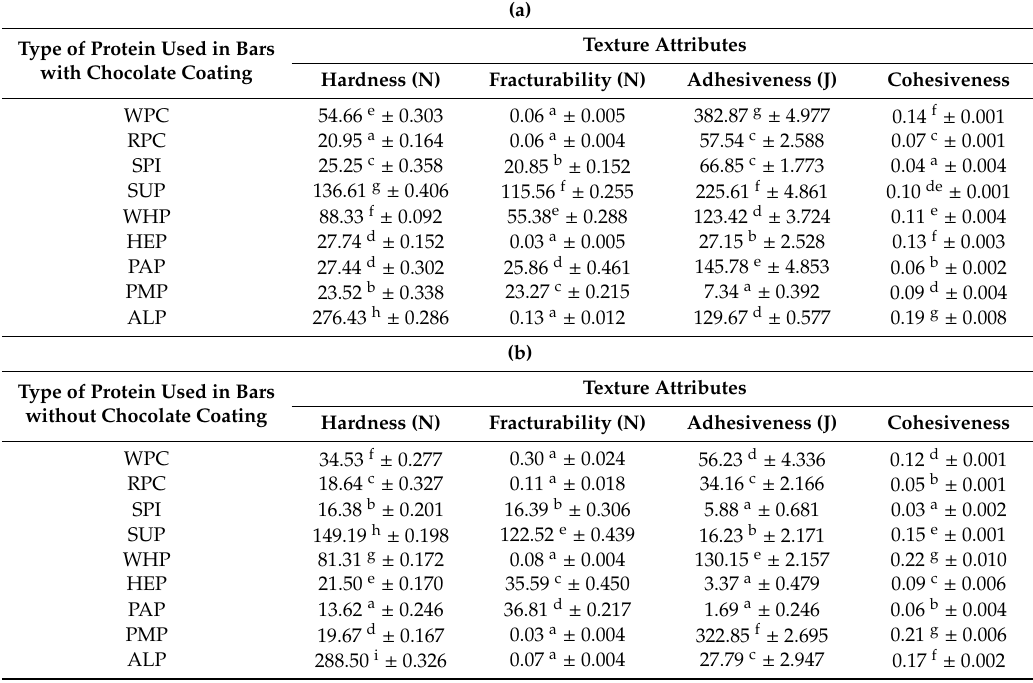
Table 2. E ff ect of di ff erent protein application on high-protein bars texture attributes. ( a ) Data are presented as means ± SD (standard deviation). a–h Means in the same column with di ff erent superscripts are significantly di ff erent ( p < 0.05, Tukey’s honest significant di ff erence “HSD” test). ( b ) Data are presented as means ± SD (standard deviation). a–i Means in the same column with di ff erent superscripts are significantly di ff erent ( p < 0.05, Tukey’s HSD